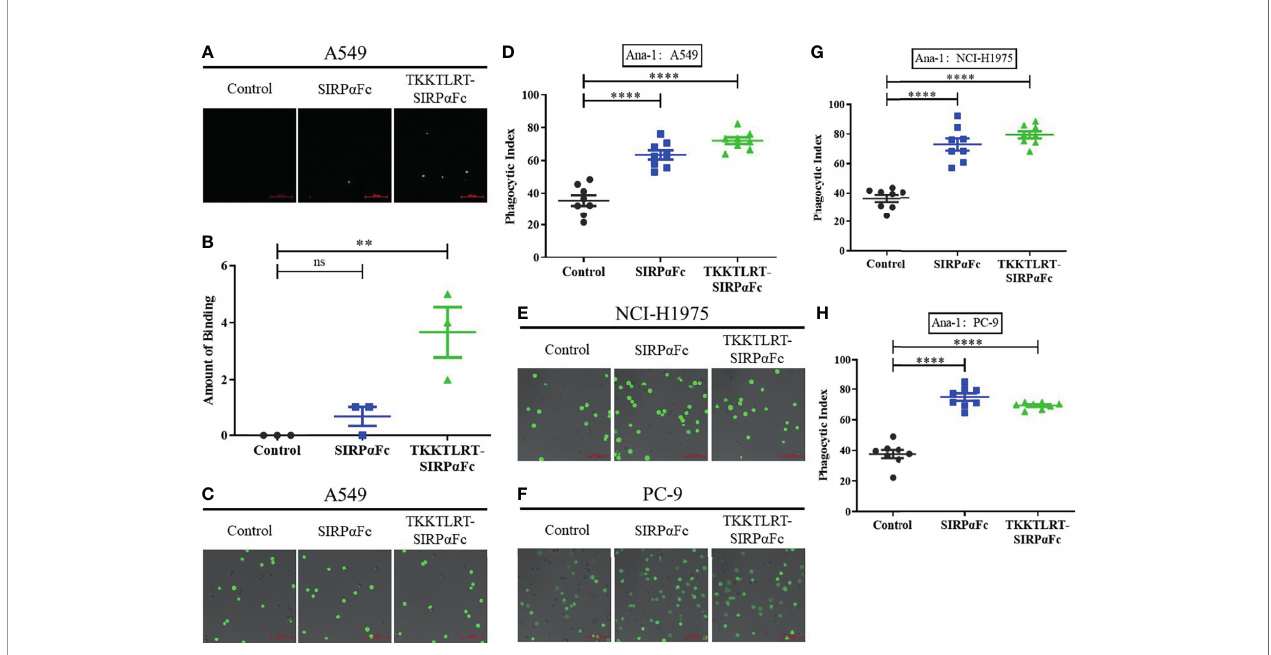
FIGURE 3 | CBD – SIRP a Fc retained the coincident in vitro effect as SIRP a Fc. (A, B) CBD conjugation made SIRP a Fc derive the ability of binding collagen and tumor cells simultaneously. Signi fi cantly more CFDA SE-labeled A549 cells were binding to the CBD – SIRP a Fc-incubated group in collagen-coated wells than to the SIRP a Fc group (n = 3, mean ± SD ns, no signi fi cant, ** p < 0.0021). (C – H) Phagocytosis of Ana-1 macrophages to A549, NCI-H1975, and PC-9 was detected using the laser confocal fl uorescence microscope while tumor cells were labeled with CFDA SE (C, E, F) . Macrophages that swallowed tumor cells or not were counted respectively, and the phagocytic index was calculated, in which SIRP a Fc and CBD – SIRP a Fc showed a similar promoting effect on phagocytosis (n = 8, mean ± SD, **** p < 0.0001) (D, G, H)